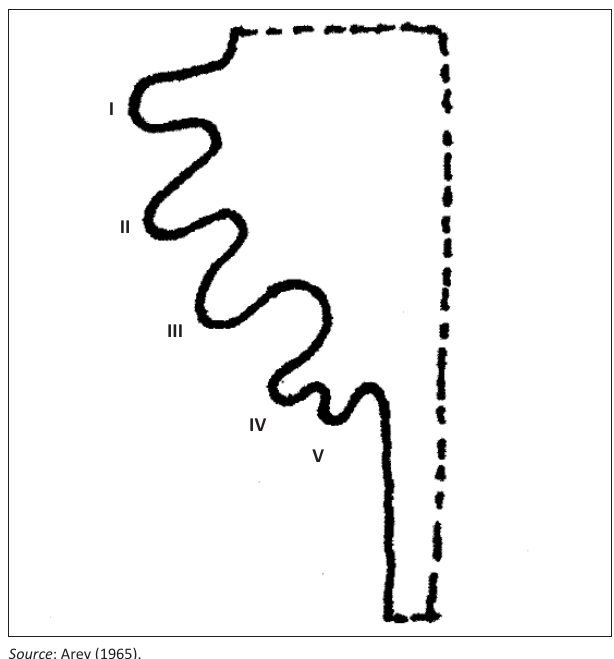
FIGURE 1: External view of branchial arches I, II, III and IV separated by branchial grooves.